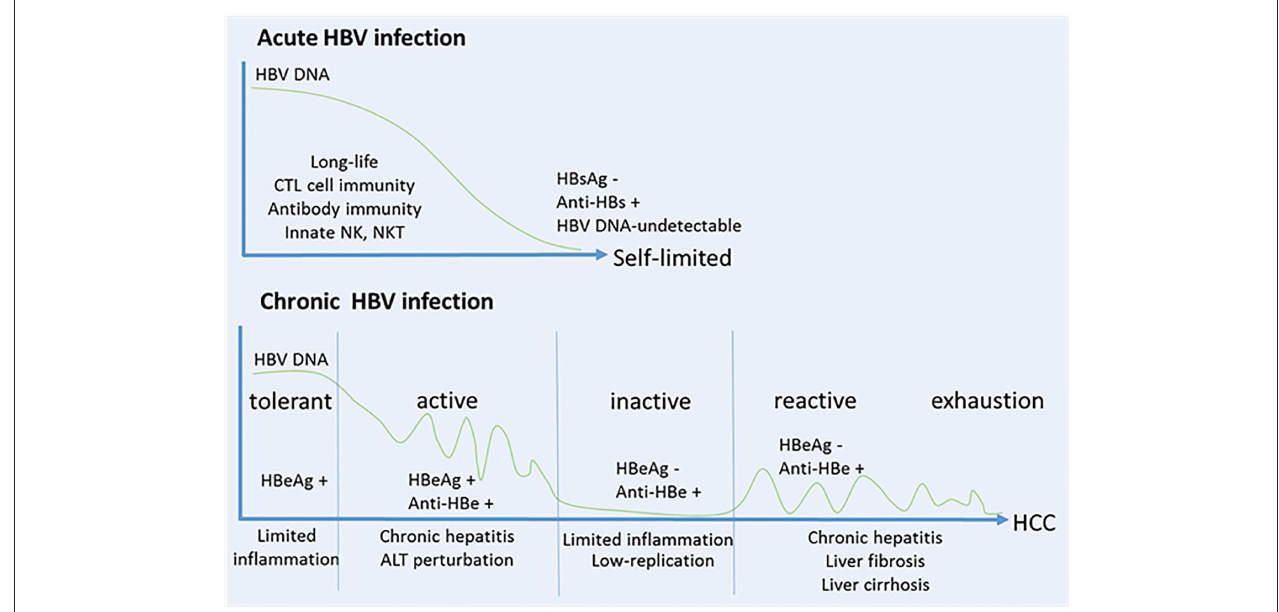
FIGURE 1 | HBV infection relates to the magnitude and quantity of anti-viral immune response. (A) Self-limited acute HBV infection. NK cells and NKT cells play important roles in early control of HBV, and then a robust response of CD4 + T cells and CD8 + T cells is generated to control and eliminate HBV. B cells co-stimulated by T cells produce anti-HBs, anti-HBe and anti-HBc. These protective antibodies clear HBV antigens and virus from the circulation, and prevent or limit HBV reinfection. (B) Chronic HBV infection. Five stages are identified including “immune tolerant” stage with a high-replication of HBV-DNA and low-inflammation, “immune active” stage with HBV-specific CD8 + T cell response and antibody production which results in chronic liver injuries, inflammations and liver regeneration, “immune inactive” stage with low-replication of HBV and limited inflammation, “immune reactive” stage with chronic hepatitis progressed to liver fibrosis, cirrhosis and HCC, and in the late stage of “immune